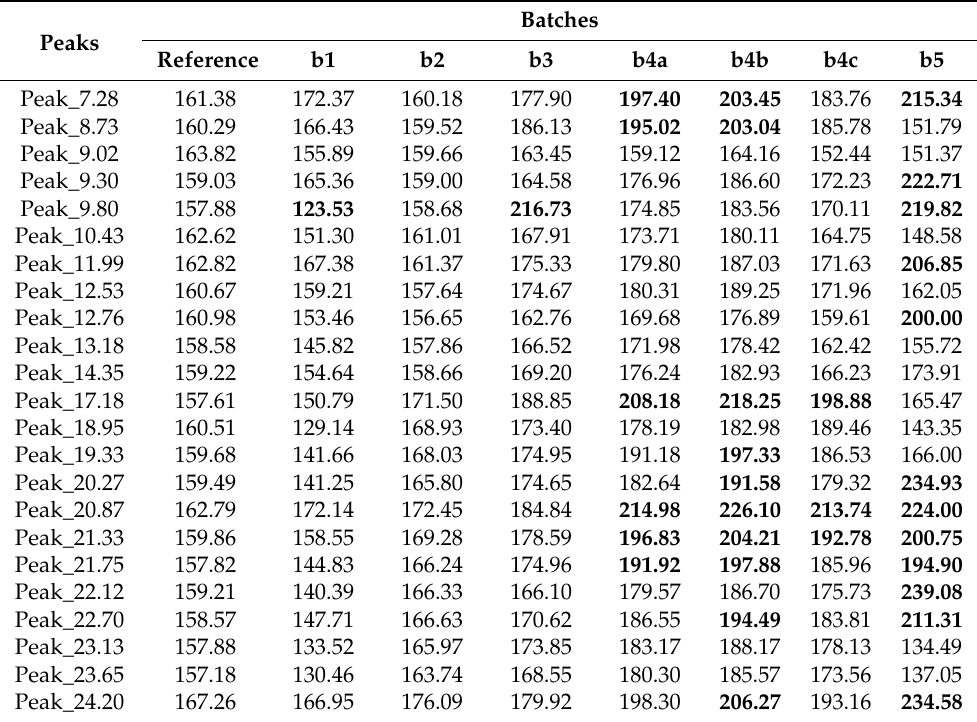
Table 2. Interpolated values ( µ g mL − 1 ) of the CMS compounds for the tested and the reference batches as they were calculated by the linear regression models developed in MEPHAS. The peaks that presented % Error > 20.0 from the reference value are